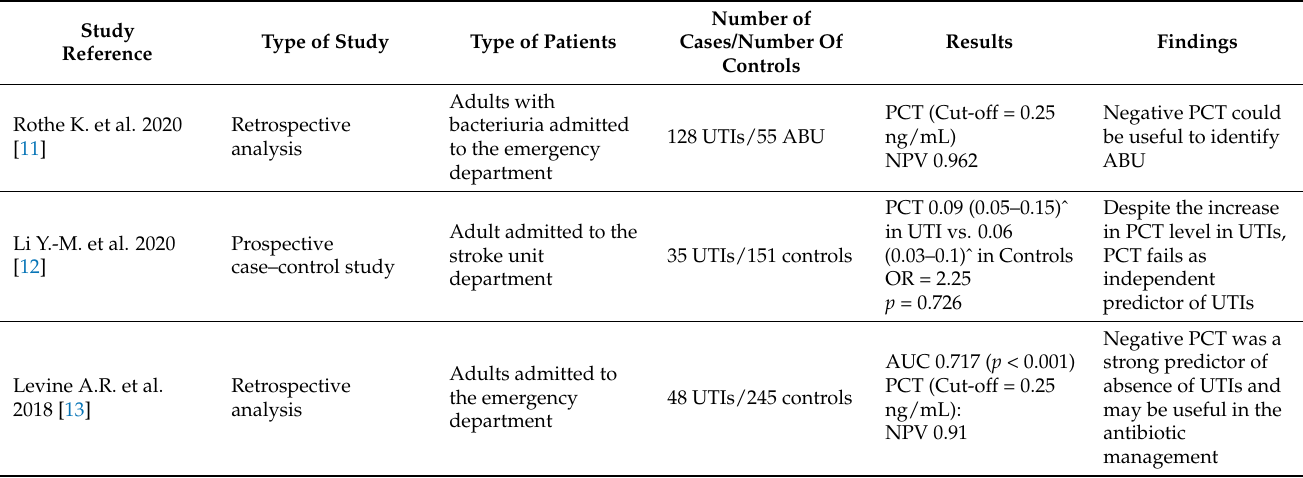
Table 1. Procalcitonin diagnostic value in UTIs, in a target population of